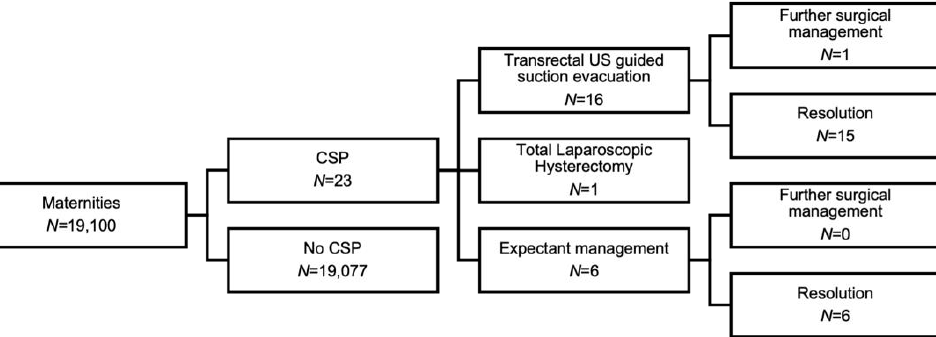
Figure 2. Flowchart of Caesarean Scar Pregnancy cases and management .